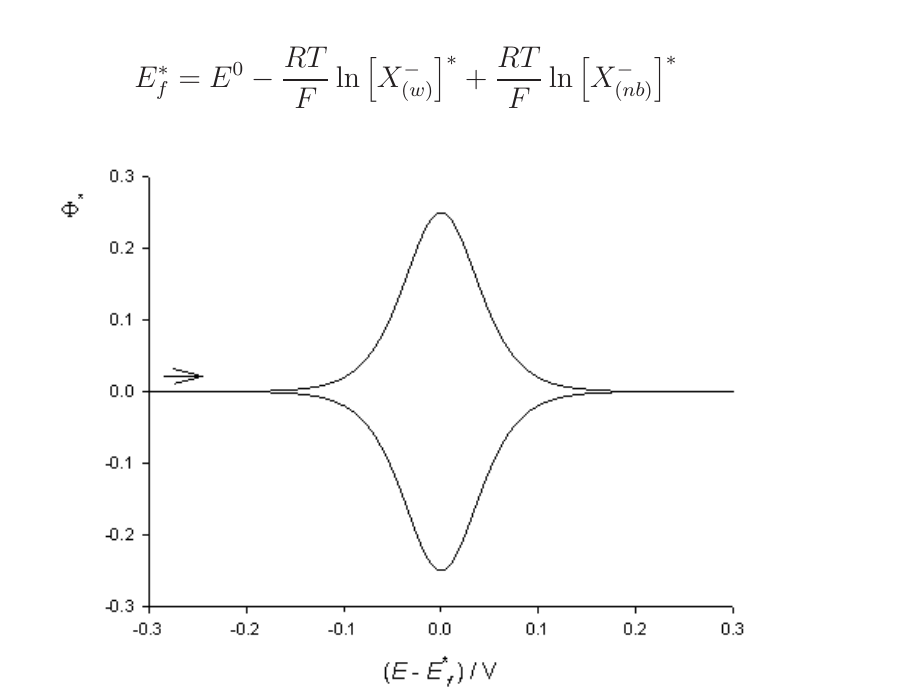
Fig. 3 Cyclic voltammogram of reversible reaction (1) in the superfluity of anion X − in the film (eq.